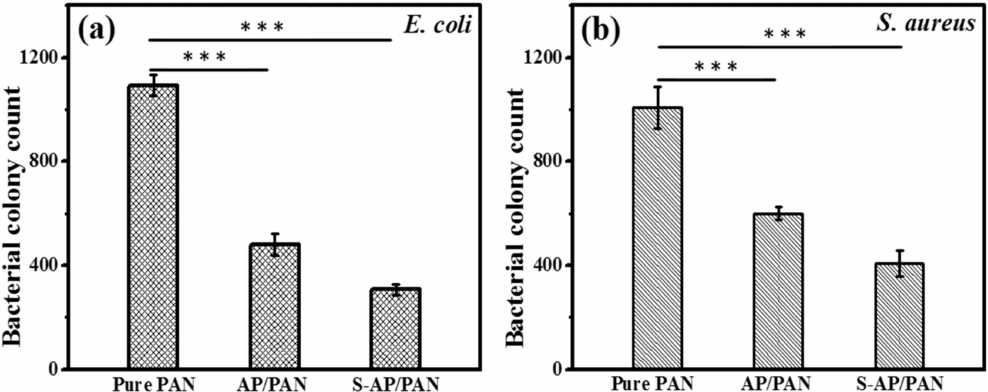
Figure 8. Number of colonies; ( a ) E. coli and ( b ) S. aureus grown on Tryptic soya agar plates after treatment with pure PAN, AP / PAN and S-AP / PAN. AP / PAN and S-AP / PAN showed significant levels of bacterial growth suppression activity compared to Pure PAN statistically assessed by one-way ANOVA using SPSS software. p < 0.05 considered as significant and represented as * p < 0.05, ** p < 0.01 and *** p <